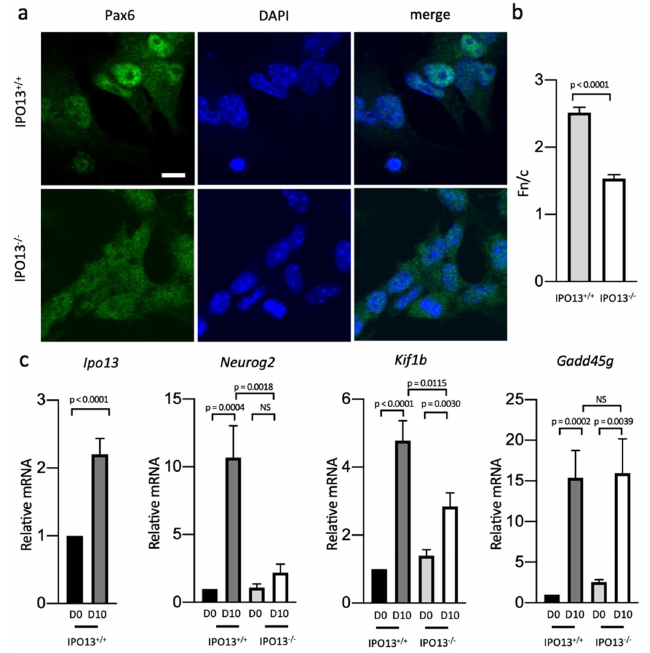
Figure 3. Decreased Pax6 nuclear accumulation in D10 IPO13 − / − cells results in reduced Pax6 tran- scriptional activity . ( a ). Representative images of Pax6 immunostaining at D10 in IPO13 +/+ and transcriptional activity. ( a ). Representative images of Pax6 immunostaining at D10 in IPO13 +/+ and IPO13 − / − cells. Scale bar = 10 µm. ( b ). Quantitative analysis of Pax6 localisation was carried out using the ImageJ software on images, such as those in ( a ) to determine the nuclear to cytoplasmic ratio IPO13 − / − cells. Scale bar = 10 µ m. ( b ). Quantitative analysis of Pax6 localisation was carried (Fn/c). Data represent the mean ± SEM for the nuclear (Fn) and cytoplasmic fluorescence (Fc) above background fluorescence. p values as per Figure 1d ( c ). RNA was extracted from IPO13 +/+ and IPO13 − / − mESC at D0 and D10. Transcript levels were assessed using the SensiMix SYBR Green. Results for gene expression were normalised to the expression of housekeeping genes Sdha , Tbp , and 18s . Data were relativised to the IPO13 +/+ D0 expression values. Results represent the mean ± SEM ( n = 7, where each cDNA sample was measured in duplicate). p values are as per Figure 1d.